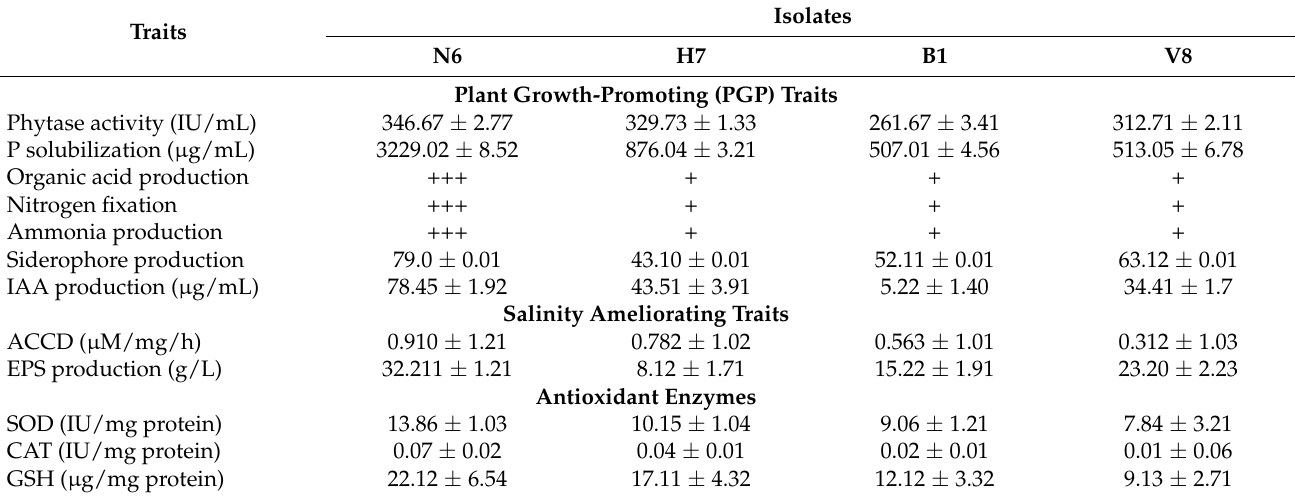
Table 1. Screening for the production of PGP traits of various